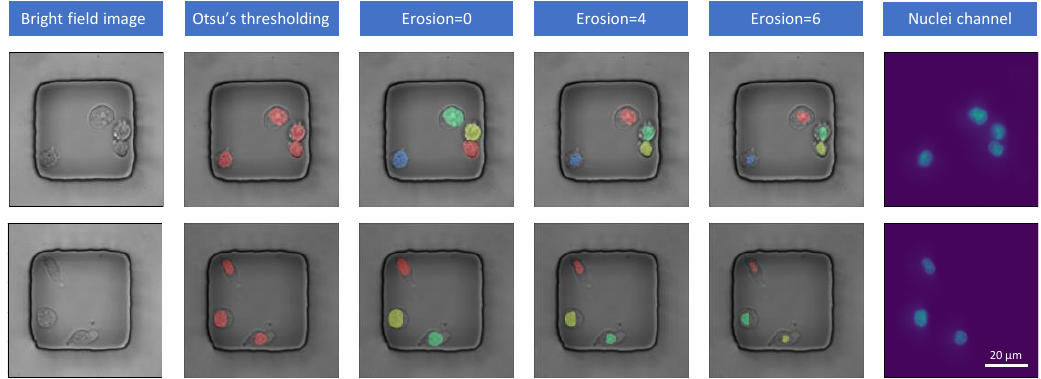
Figure 3. Comparison of representative masks generated from nuclei channel with blob detection methods.